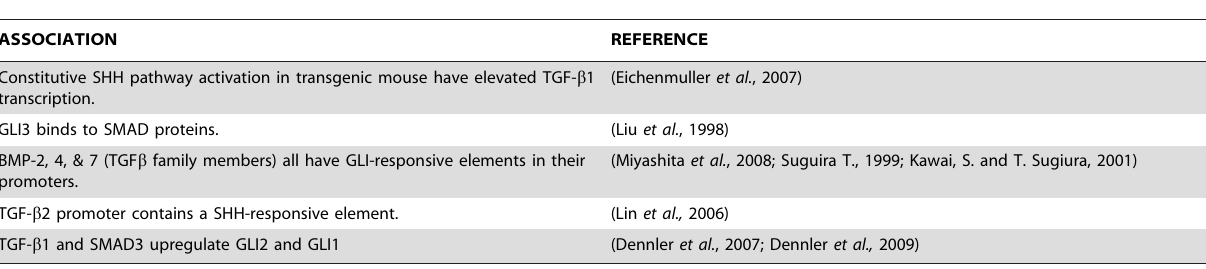
Table 1. The TGF- b and SHH Pathways Exhibit Extensive